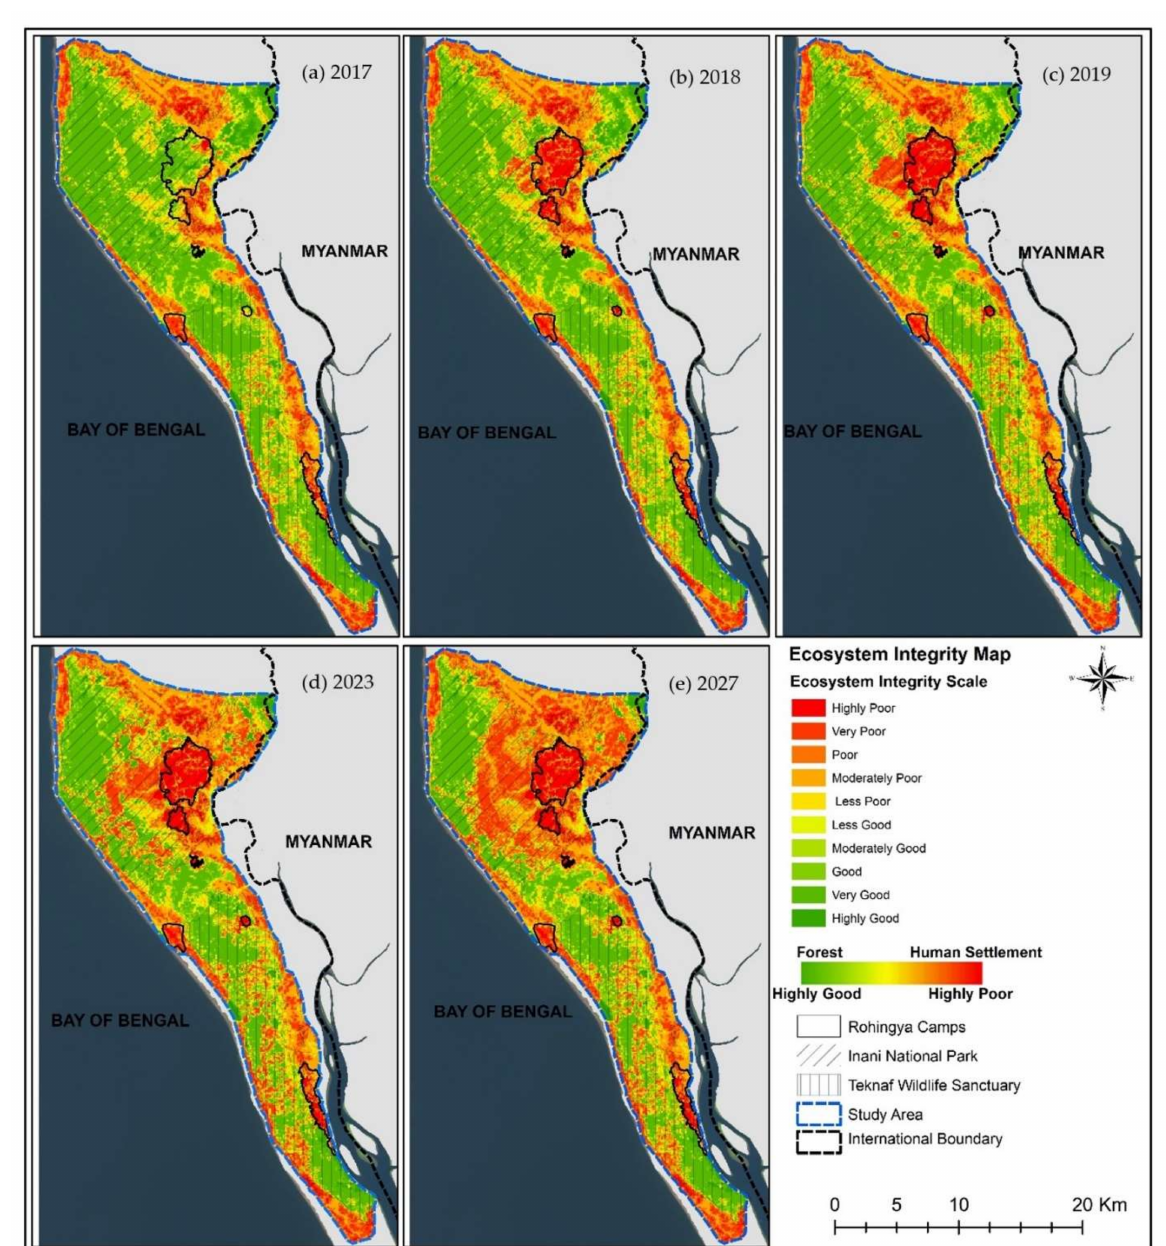
Figure 7. Spatio-temporal changes in ecosystem integrity for three temporal windows (present, past, and future). These areas represent the degraded forest areas transformed mostly from Mixed Forest (MF) and Shrub-Dominated Area (SH). In the case of the ‘Moderately Poor’ and ‘Less Poor,’ the EI value also rose, which meant a depletion of the ecosystem integrity. The positive and negative EI scores suggest a loss of ecosystem integrity due to the Rohingya influx. However, the magnitude of the EI loss is well understood from the quantitative findings of the ecosystem integrity depletion (EID) scores (Figures 9 and